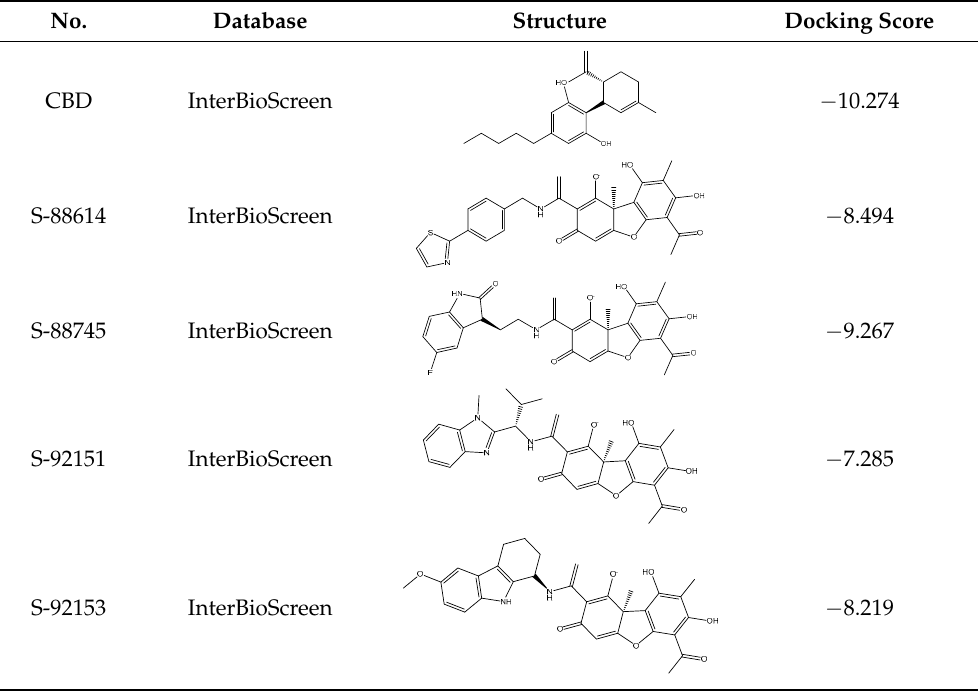
Table 2. The stereo view and floor plan view of the docking results of CBD and the selected compounds. No.